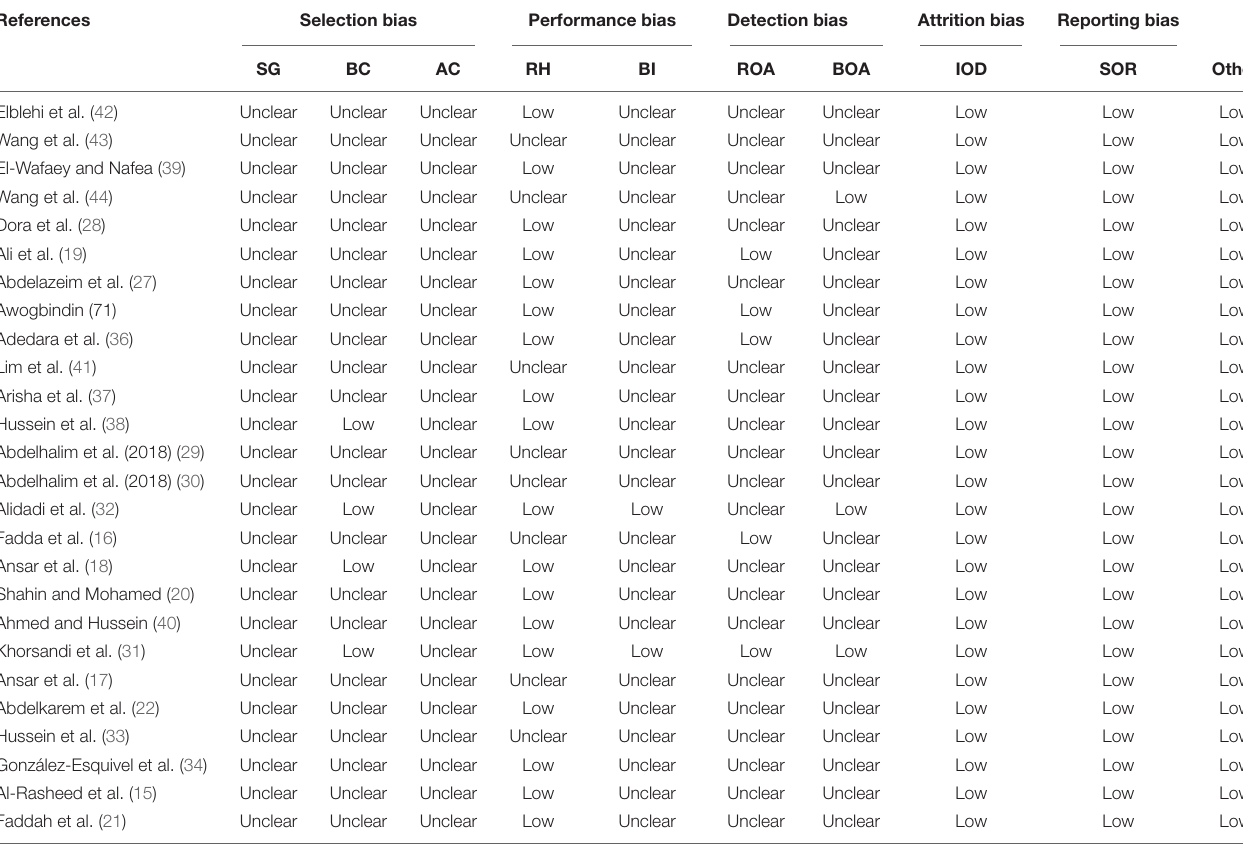
TABLE 2 | Quality assessments based on SYRCLE’s risk of bias